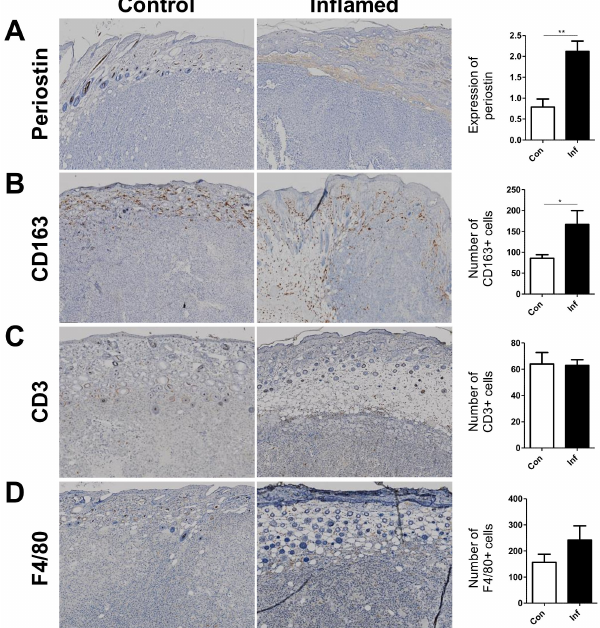
Figure 3. Stromal expression of periostin and the number of CD163 + M2 macrophages are significantly elevated in melanomas in inflamed mice, but not the number of CD3 + cells and F4/80 + cells. Left panels show representative immunohistochemical staining of ( A ) periostin, ( B ) CD163, ( C ) CD3, and ( D ) F4/80 in melanomas in control and inflamed mice. × 100 magnification. Right panels show scoring of the expression of periostin and the number of infiltrated CD163 + cells, CD3 + cells, F4/80 + cells. t -test, * p < 0.05, ** p <